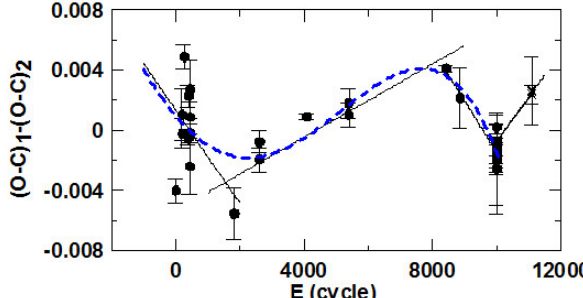
Fig. 8 Residuals of IK Boo from the quadratic ephemeris and their description by four linear ephemerides. The solid curve represents the 4 th order polynomial fit with SD =0.002 and r =